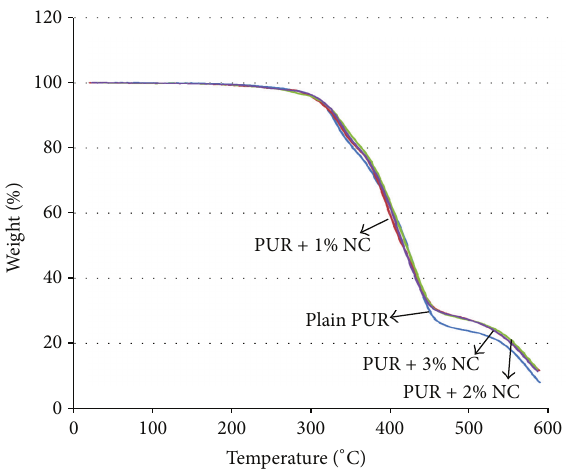
Figure 2: TGA analysis of PUR-Nanoclay composite